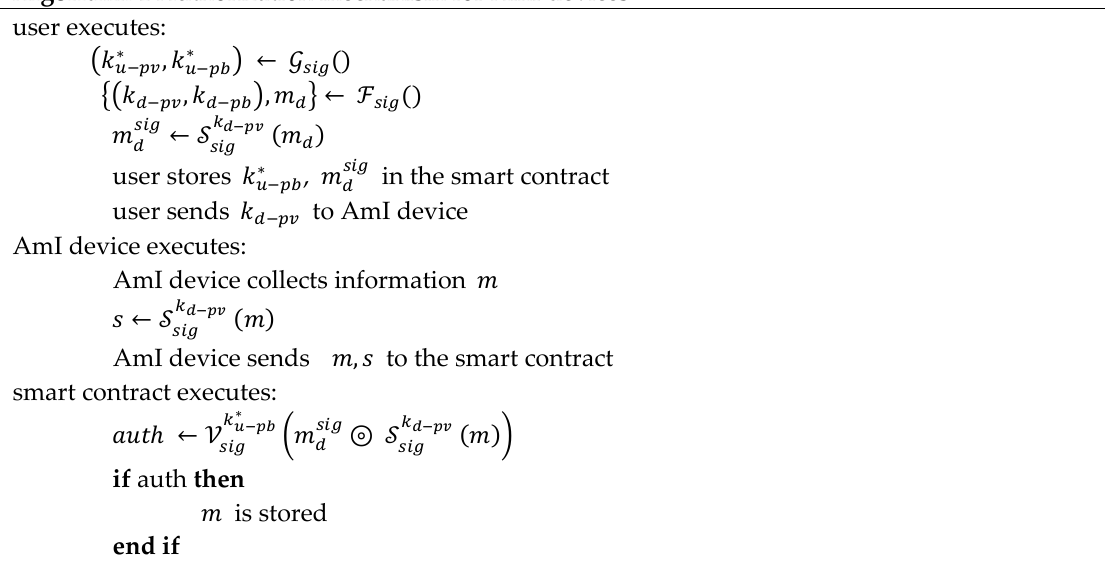
Algorithm 1 Authorization mechanism for AmI